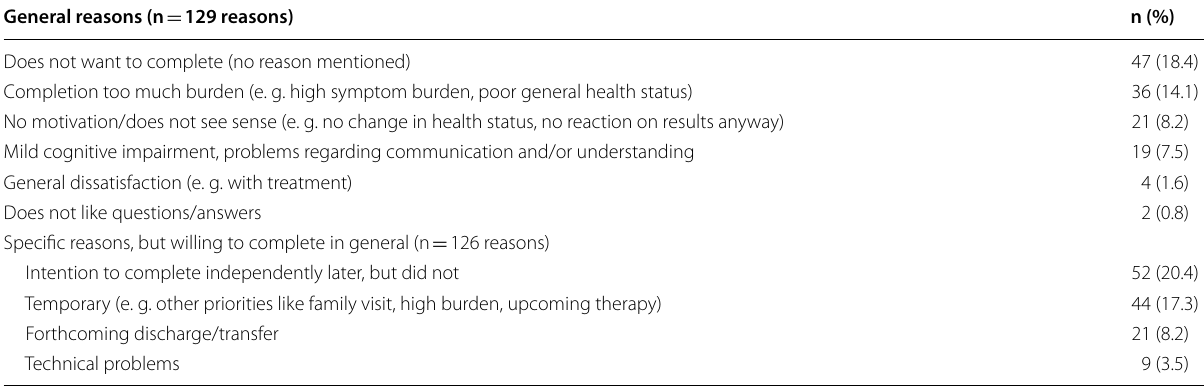
255 reasons stated in n =